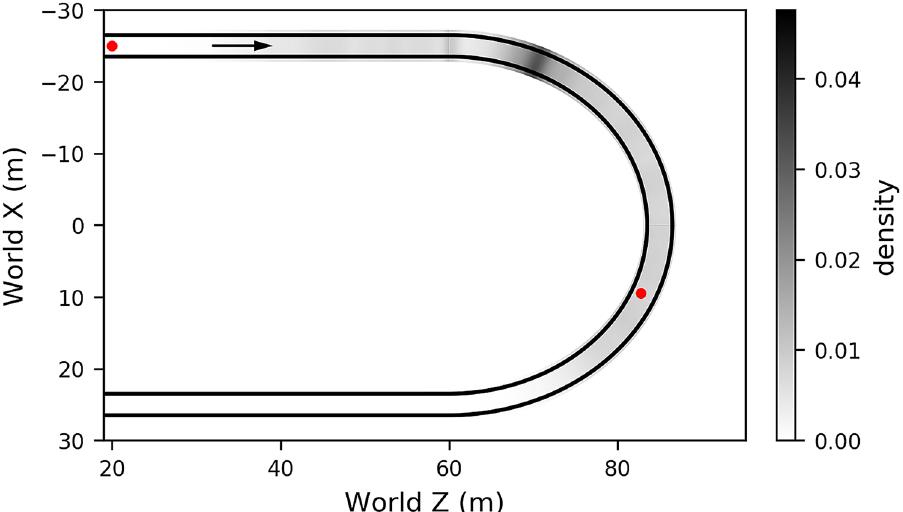
Figure 5. Gaze on track density. The density of the gaze midline reference (see Estimating a Gaze Time Headway Signal ), pooled across participants. Note the spike in gaze density approximately 1 s after the bend entry. Red dots mark the vehicle position at the start and the end of the trial (i.e. the gaze data on the straight after the bend is